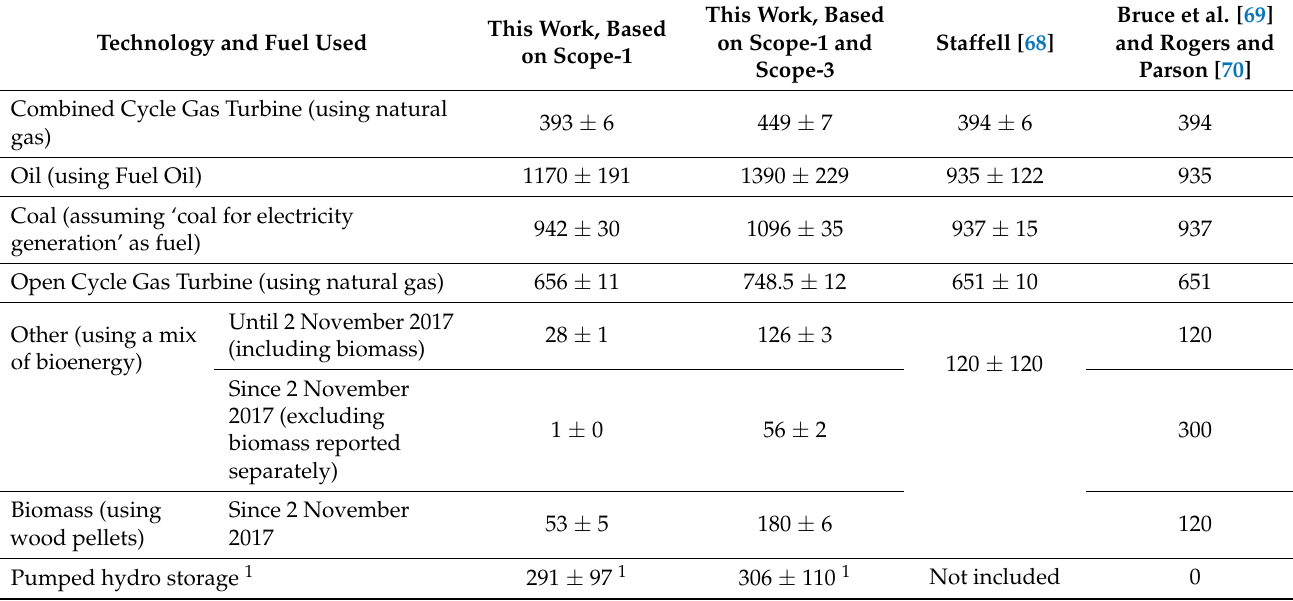
Table A1. CIs per fuel and technology, calculated according to the methodology in Section 2. Scope-1 emissions are calculated in the article; however, scope-1 and scope-3 emissions are calculated with the same methodology and using